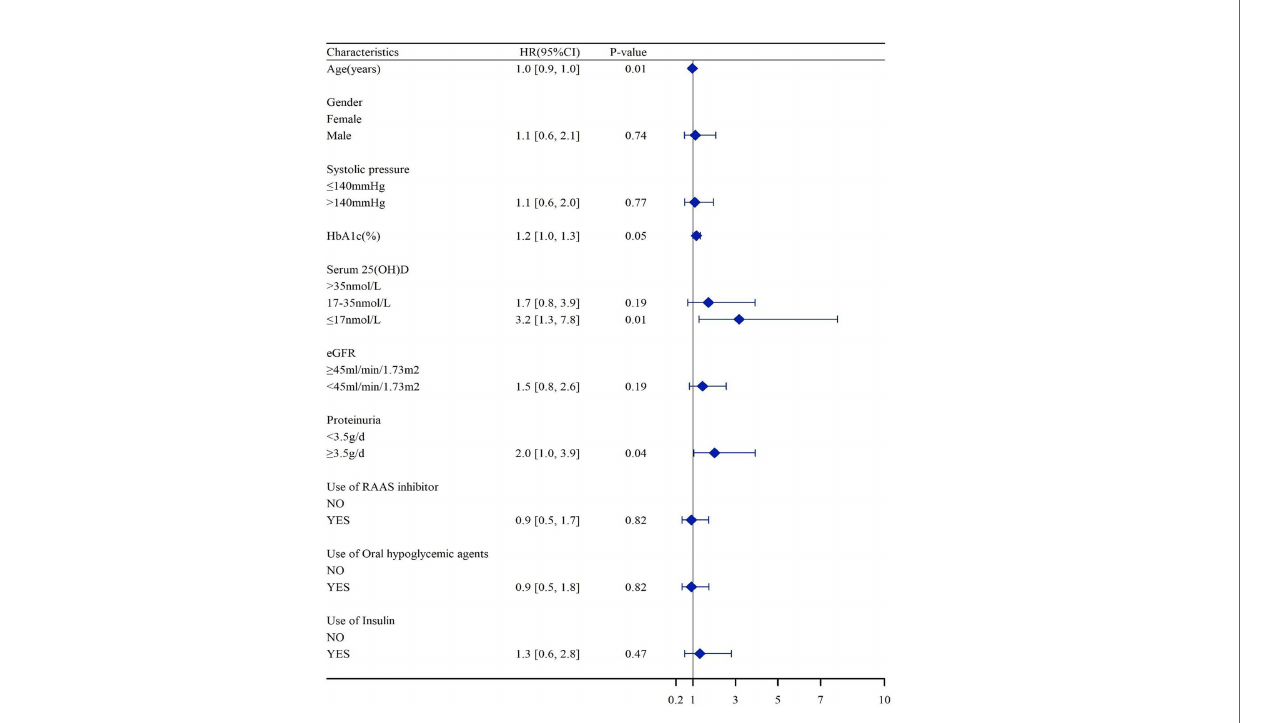
FIGURE 4 | Association of the serum 25(OH)D levels with HR of CKD progressions. Hazard ratios were adjusted for baseline age, gender, HbA1c, 24-h urinary protein, systolic blood pressure, use of RAASi, oral hypoglycemic agents, and insulin. eGFR, estimated glomerular fi ltration rate; HbA1c, glycosylated hemoglobin; RAASi, renin-angiotensin-aldosterone system inhibitor.